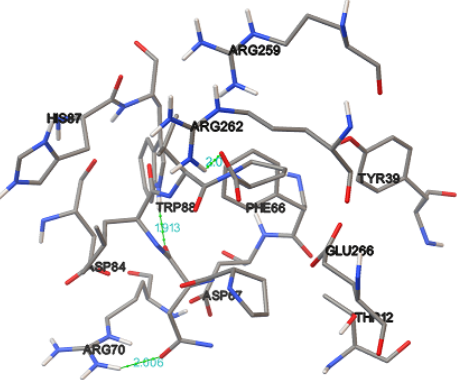
Figure 7. Docking of ( A ) NBD protein; ( B ) K71L and ( C ) T204V mutants with the E1A32 kDa motif. Hydrogen bonds are shown by a green line with its distance